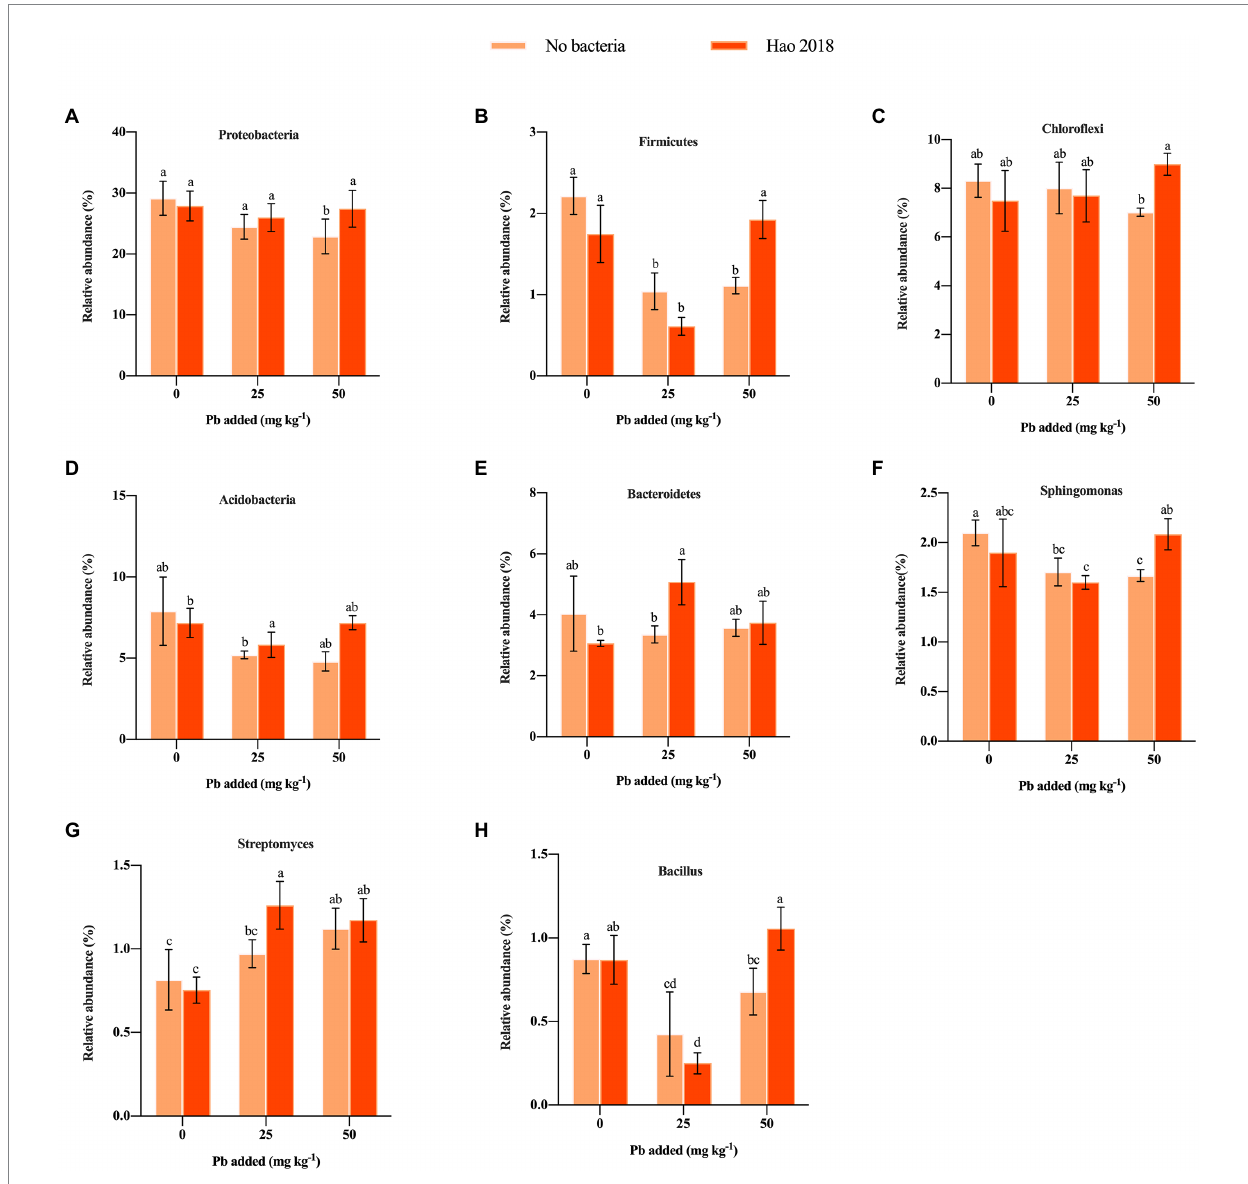
FIGURE 7 The influence of Hao 2018 on the relative abundances of the phyla Proteobacteria (A) , Firmicutes (B) , Chloroflexi (C) , Acidobacteria (D) , and Bacteroidetes (E) , and the genera Sphingomonas (F) , Streptomyces (G) , and Bacillus (H) in rhizospheric soil. Each bar represents the mean ± SD ( n = 4). The same letter indicates no significant differences between the groups ( p >